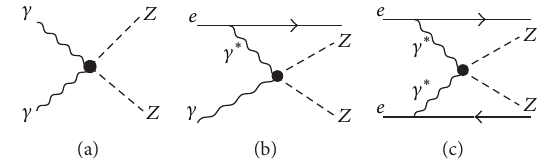
Figure 1: Tree-level Feynman diagrams for the processes (a) 𝛾𝛾 → 𝑍𝑍 , (b) 𝑒 − 𝛾 → 𝑒 − 𝛾 ∗ 𝛾 → 𝑒 − 𝑍𝑍 , and (c) 𝑒 + 𝛾 ∗ 𝛾 ∗ 𝑒 − → 𝑒 + 𝑍𝑍𝑒 − .